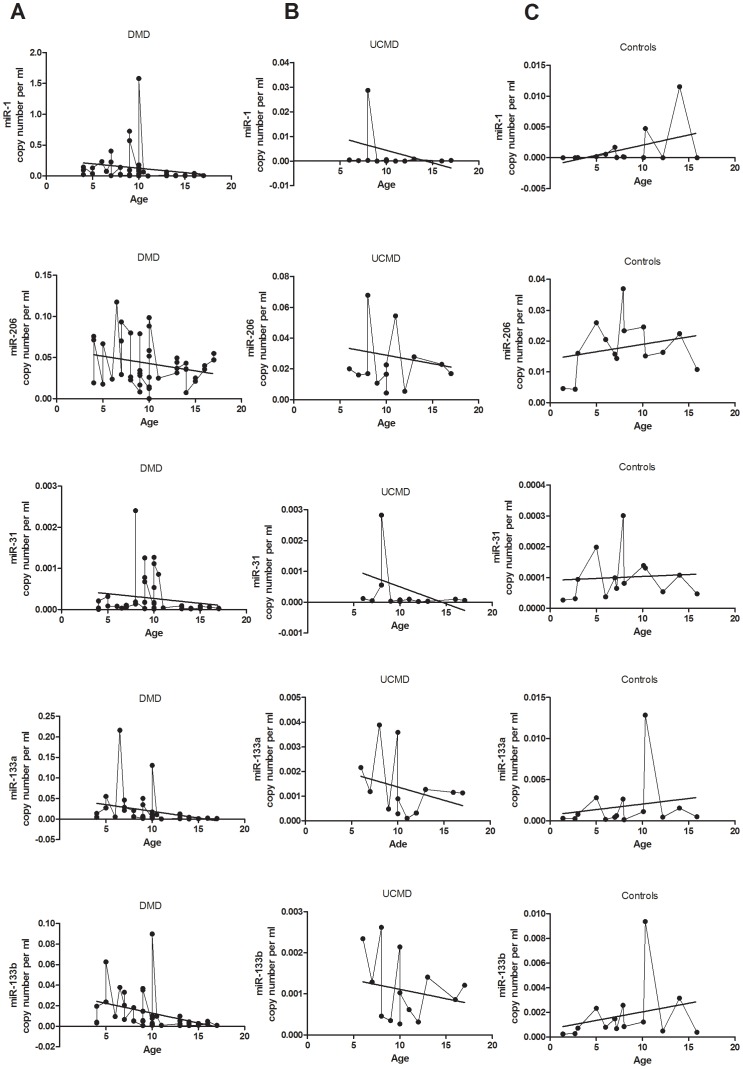
Age profile of miR-1, miR-206, miR-31, miR-133a and miR-133b in serum samples.Level of miR-1, miR-206, miR-31, miR-133a and miR-133b in serum samples according to the age of the: A. DMD patients; B. UCMD patients; C. healthy controls. The data are presented as miRNA copy number per ml normalized to the spiked-in C. elegance miRNAs (cel-miR-54, cel-miR-39, cel-miR-238). Regression line is also presented.